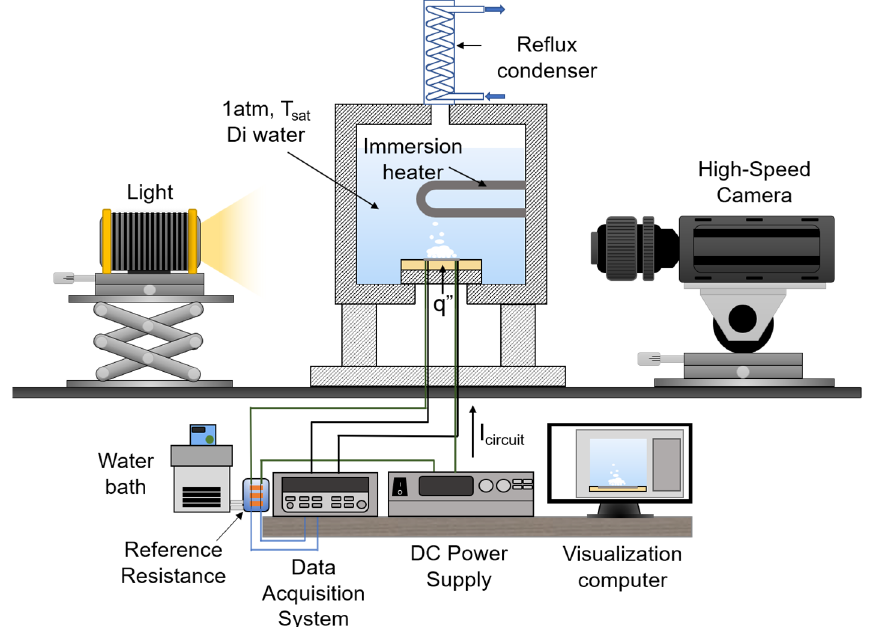
Figure 3. The pool boiling experimental apparatus.